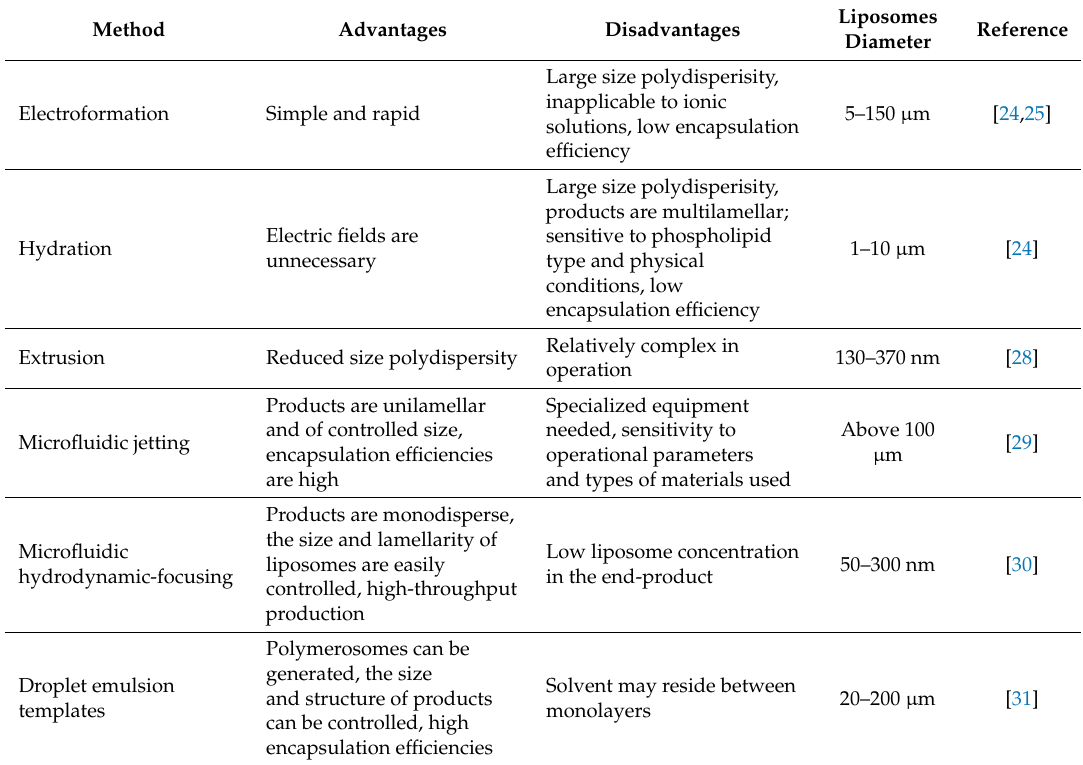
Table 1. Advantages and disadvantages of different methods based on microfluidics used to fabricate